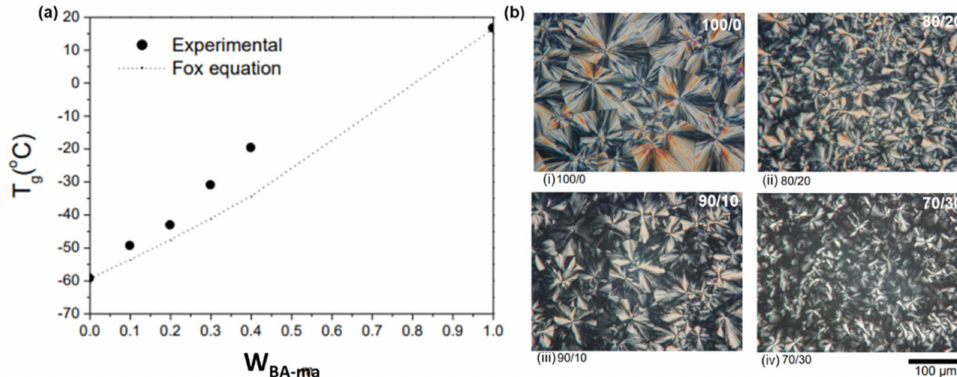
Figure 57. ( a ) T g -composition dependence of PCL/BA − ma blends, ( b ) spherulitic morphologies of PCL/BA-ma blends under POM crystallized at T c = 35 ◦ C at different ratios (100/0, 90/10, 80/20, 70/30) [369]. Copyright 2013. Reproduced with permission from Walter de Gruyter